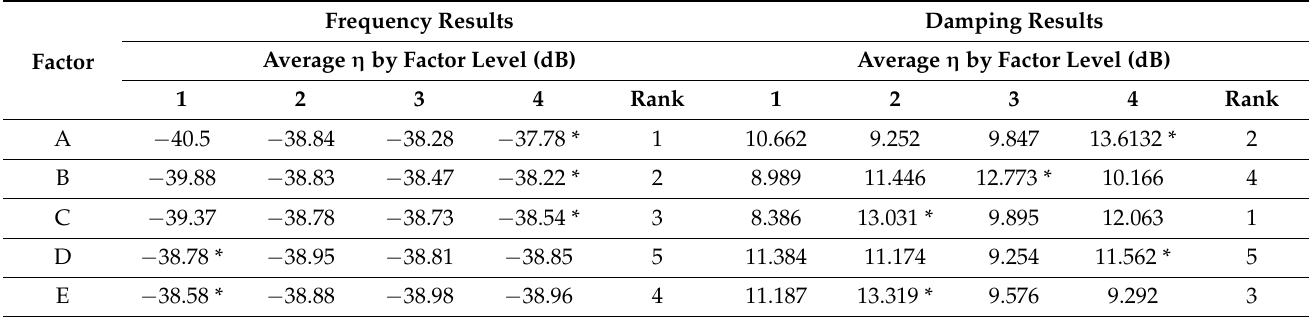
Table 4. Analysis of variance of frequency and damping